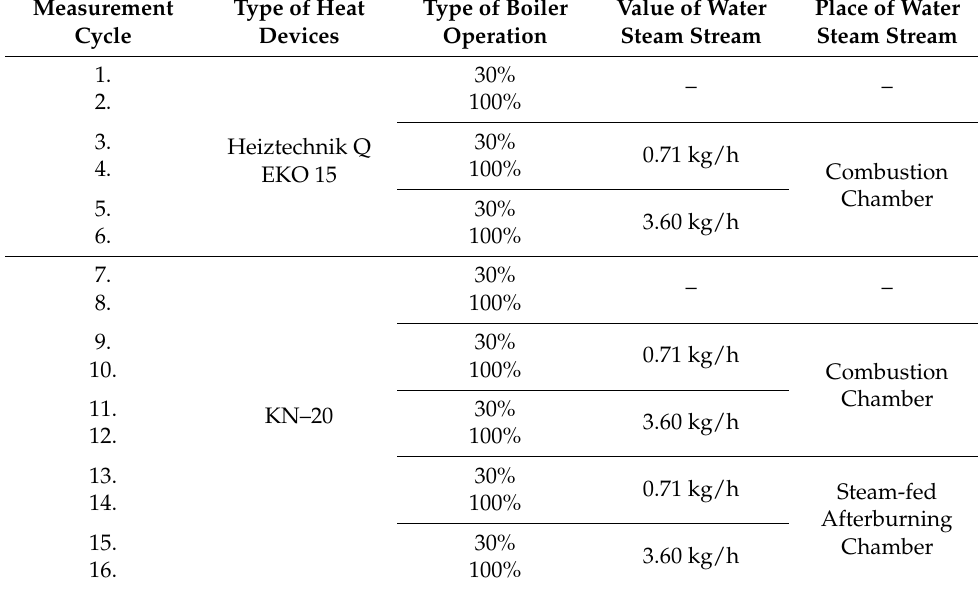
Table 1. Program of the conducted